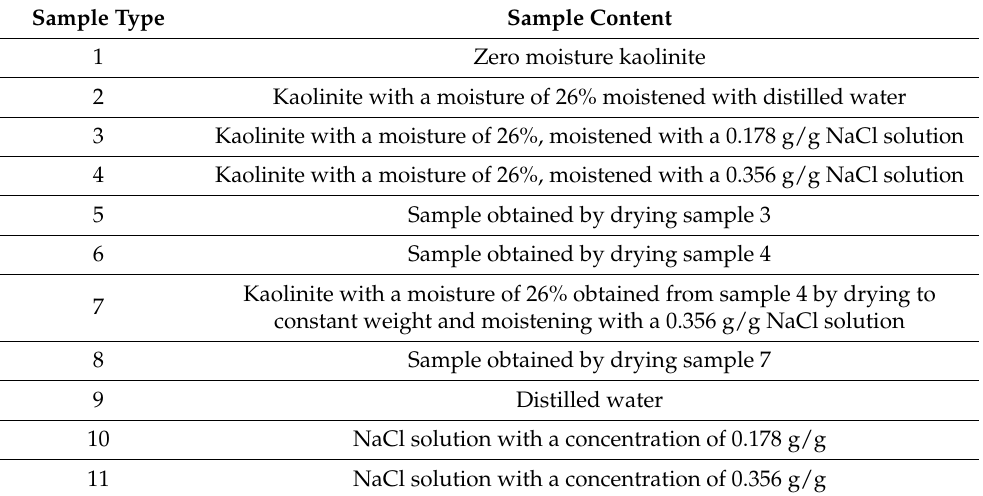
Table 1. Types of samples